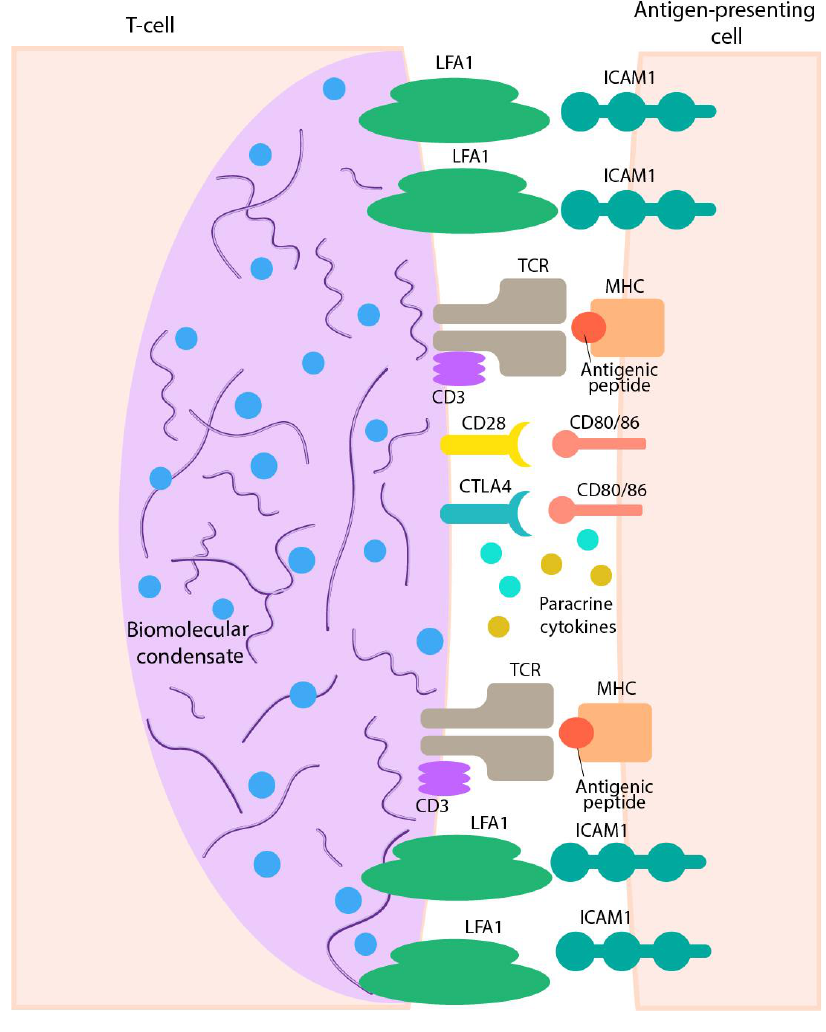
Figure 2. Simplified representation of the organization of the immunological synapse (IS) demonstrating a T-cell receptor (TCR)/CD3 complex-MHC bound peptide interactions within the synapse cleft. Clusterization of other receptors (CD28, CTLA4 with their ligands (CD80) and adhesion molecules LFA-1 and ICAM-1, on the surface of both cells, are responsible for the formation and stabilizing ISs and for the initiation of signal pathways generated by the TCRs [95,103,109]. All transmembrane contacts are clustered and have been symbolized by their pairs in the figure. Synapse formation also leads to the appearance of a biomolecular condensate (see below).